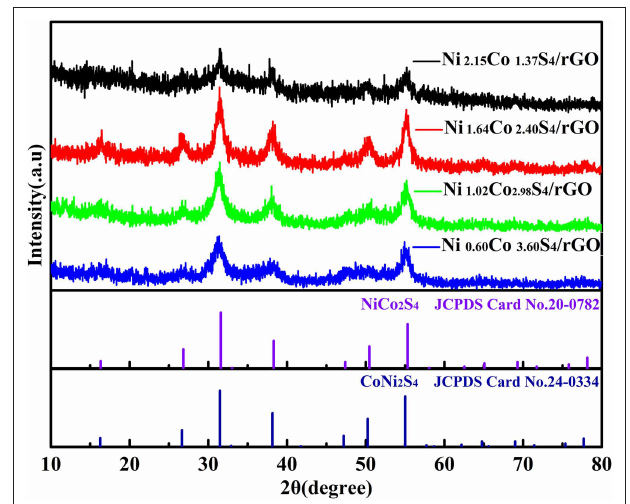
FIGURE 1 | XRD patterns of Ni x Co y S 4 /rGO